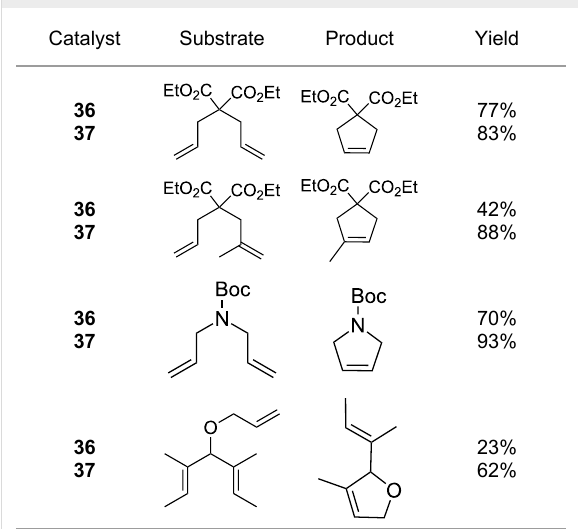
Table 6: RCM by PAG and precatalysts 36 and 37 a